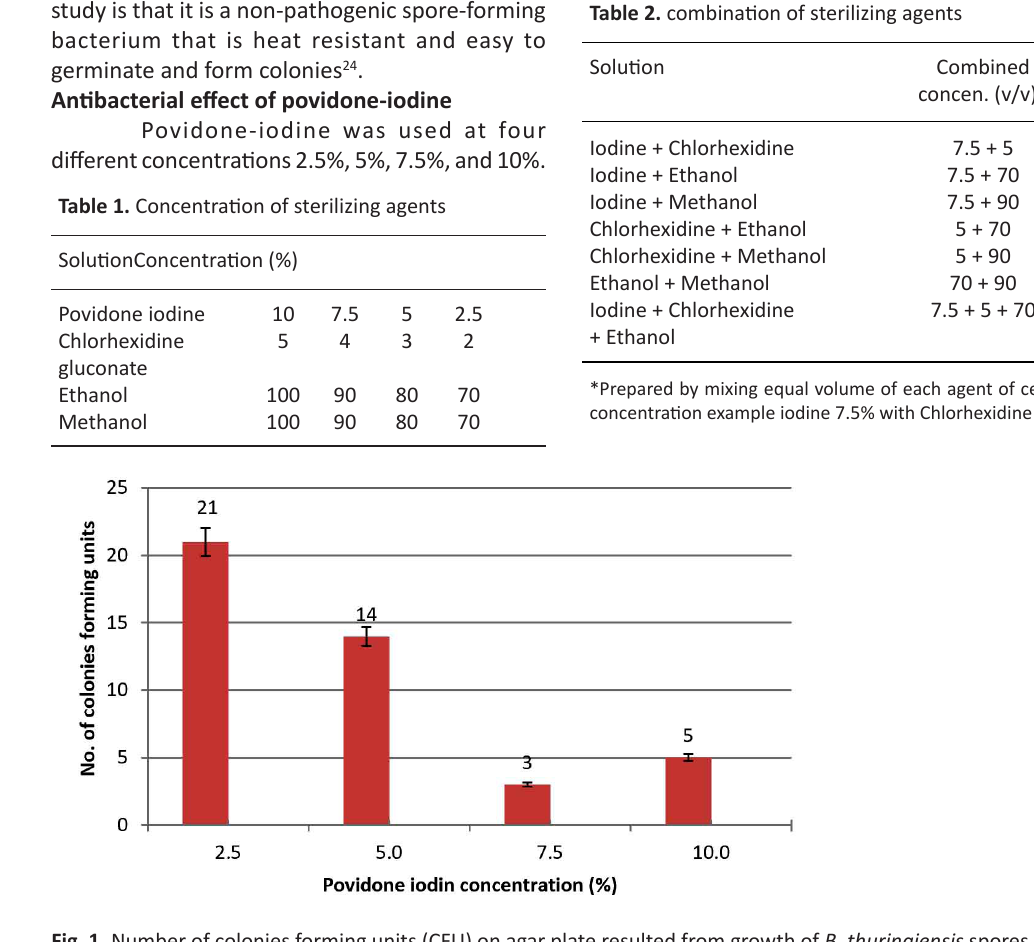
Fig. 1. Number of colonies forming units (CFU) on agar plate resulted from growth of B. thuringiensis spores after spreads 0.1 ml of spore suspension from surgical tools treated by povidone iodine